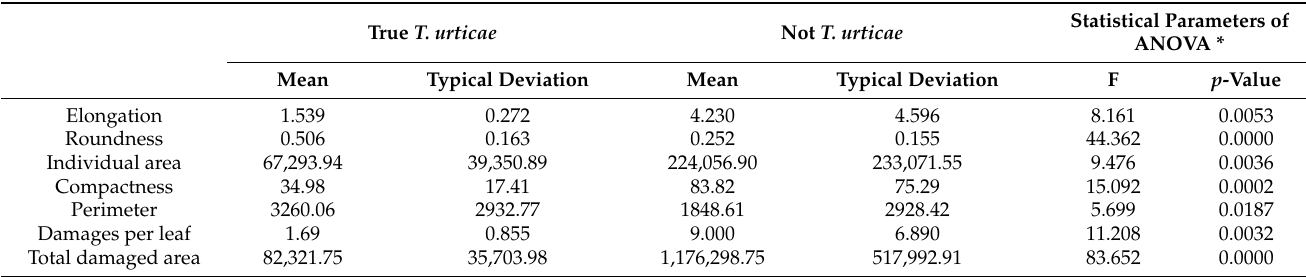
Table 3. Analysis of variance (ANOVA) of the geometrical properties of the objects found in the test images. The objects correspond to actual damages caused by T. urticae and nutritional deficiencies (not T. urticae ). True T. urticae